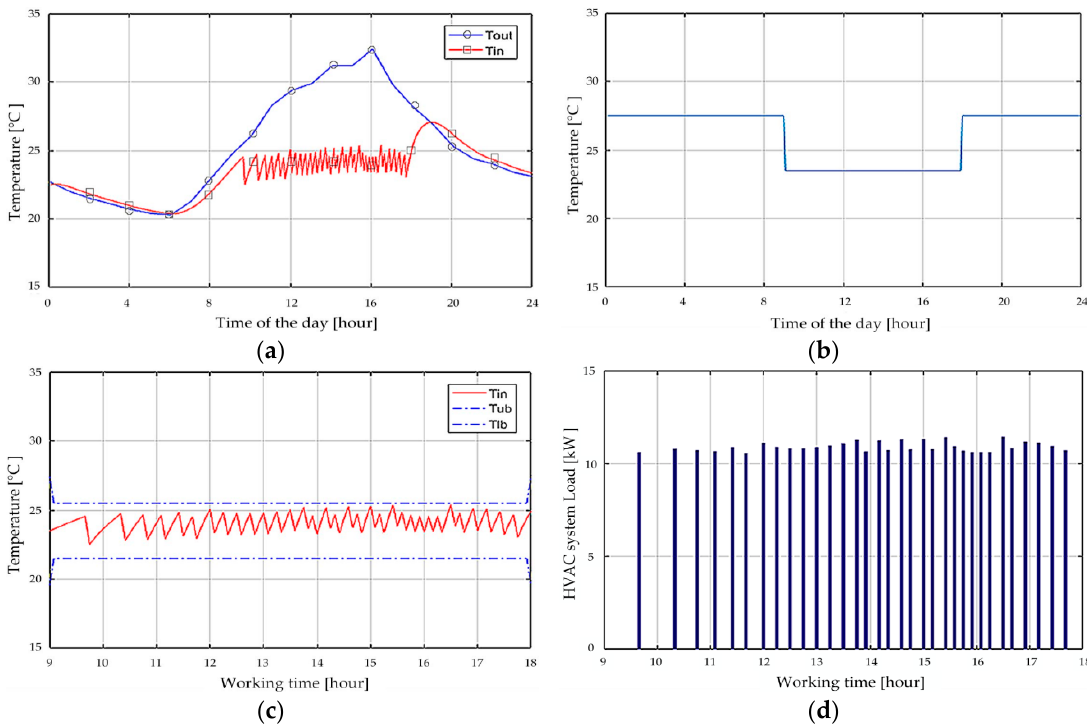
Figure 6. Case 1 simulation results. ( a ) Outdoor temperature and room temperature; ( b ) setting temperature; ( c ) indoor temperature and constraints range (work time); ( d ) HVAC system power (work time).